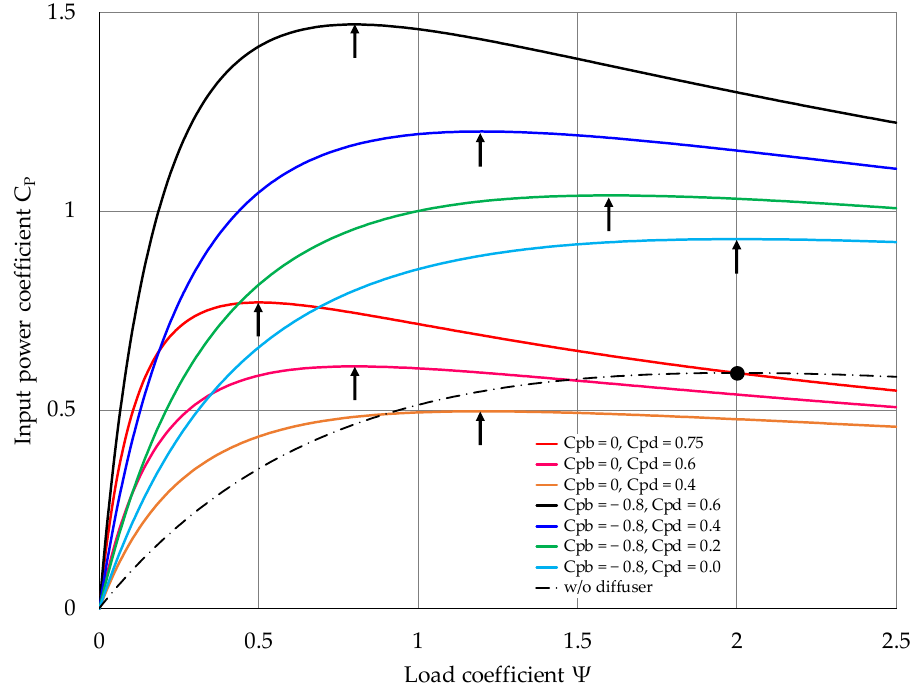
Figure 6. Variation of inlet velocity ratio K with loading coefficient.